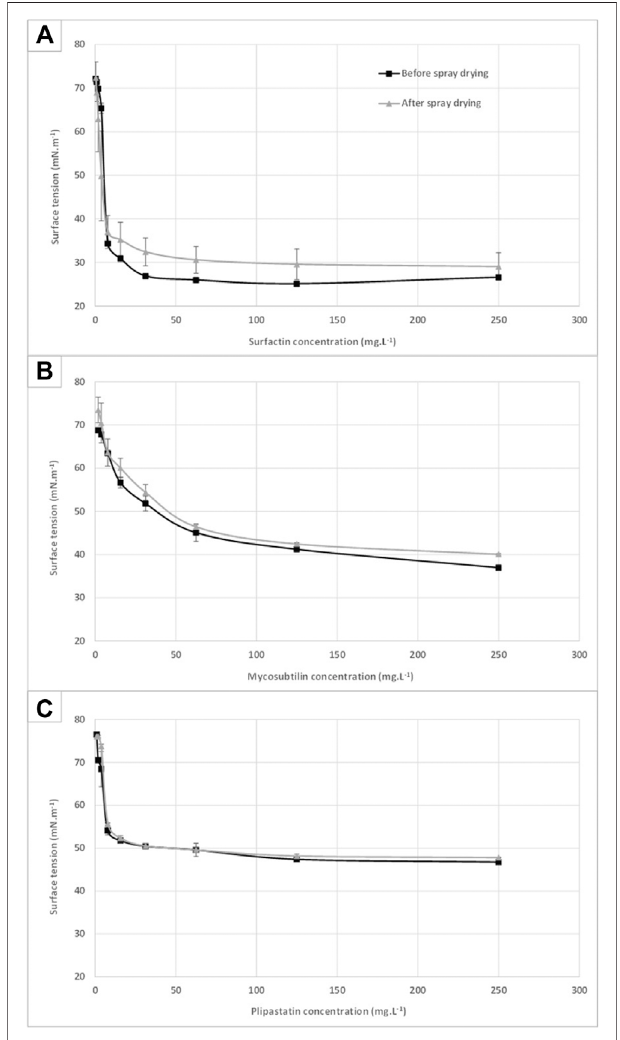
FIGURE 2 | Surface tension pro fi les of surfactin (A) , mycosubtilin (B) , and fengycin (C) samples before and after the spray-drying process. Each value is an average based on three distinct samples measured in triplicates according to the Du Nouÿ method.